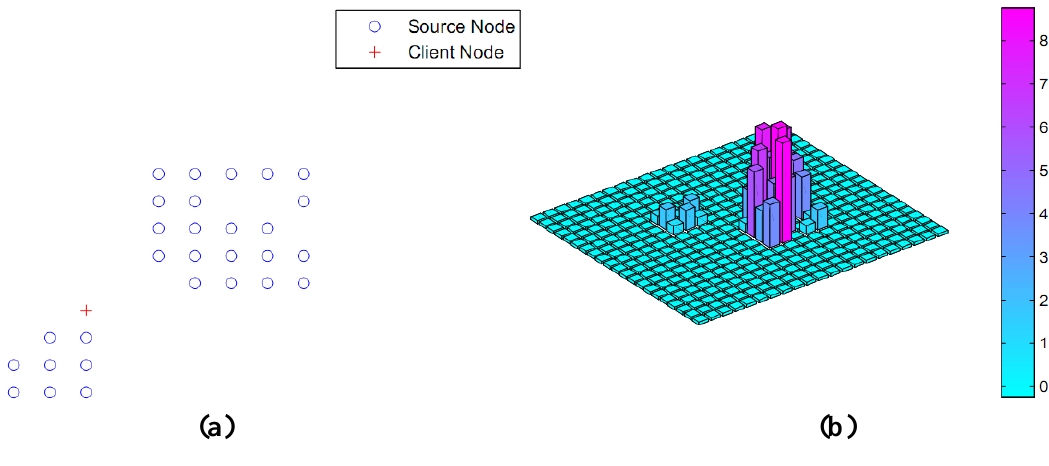
Figure 6. Topology and histogram. (a) Nodes topology; (b) Information histogram.